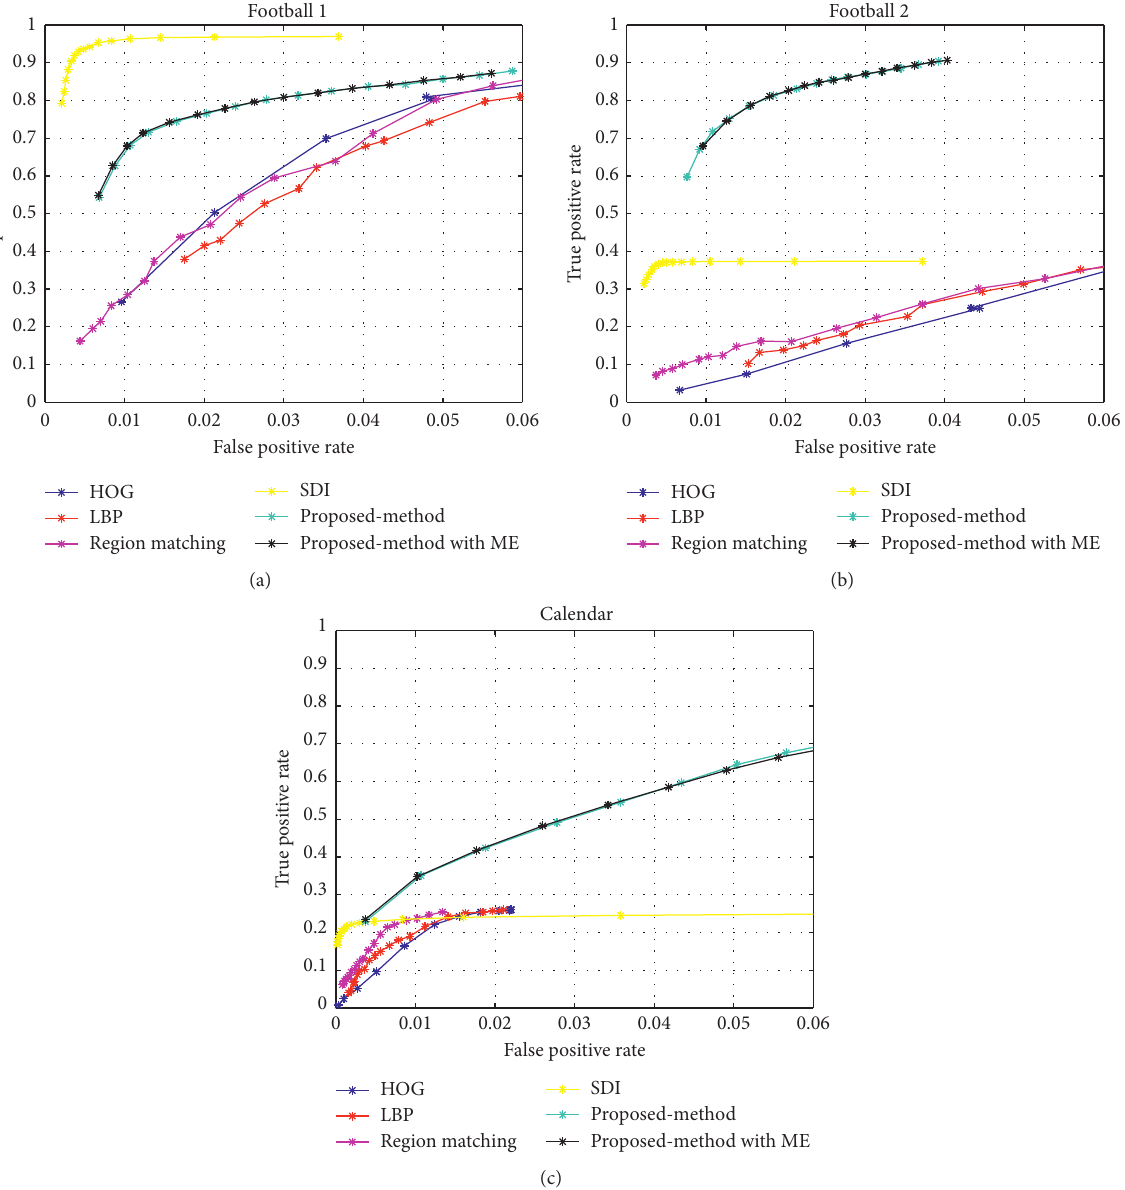
Figure 17: ROC curves for artificially degraded datasets: (a) “football _1,” (b) “football_2,” and (c)